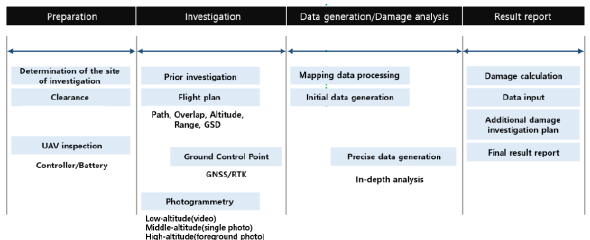
Figure 1. Disaster investigation procedure using UAV